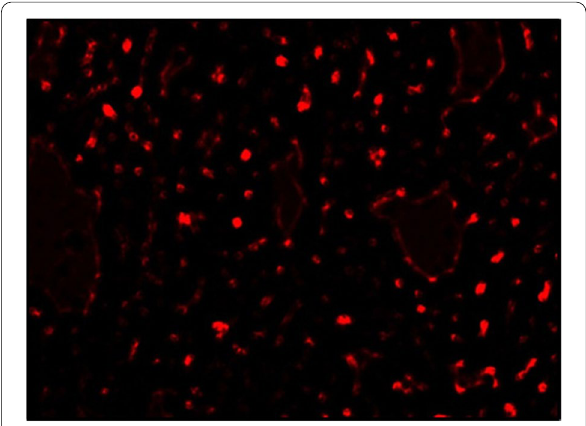
Fig. 1 Florescent micrograph of labeling stem cells. The stem cells appeared shiny and red under florescent microscope after labeling with PKH26 dye referred to by yellow arrow (